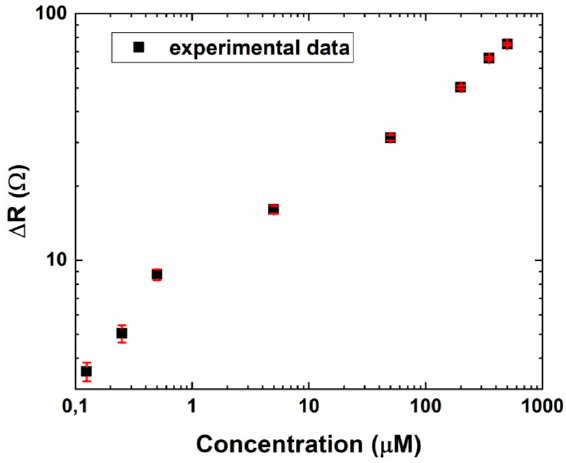
Figure 2. Calibration curve: experimental data (black squares) and relative error bars (red